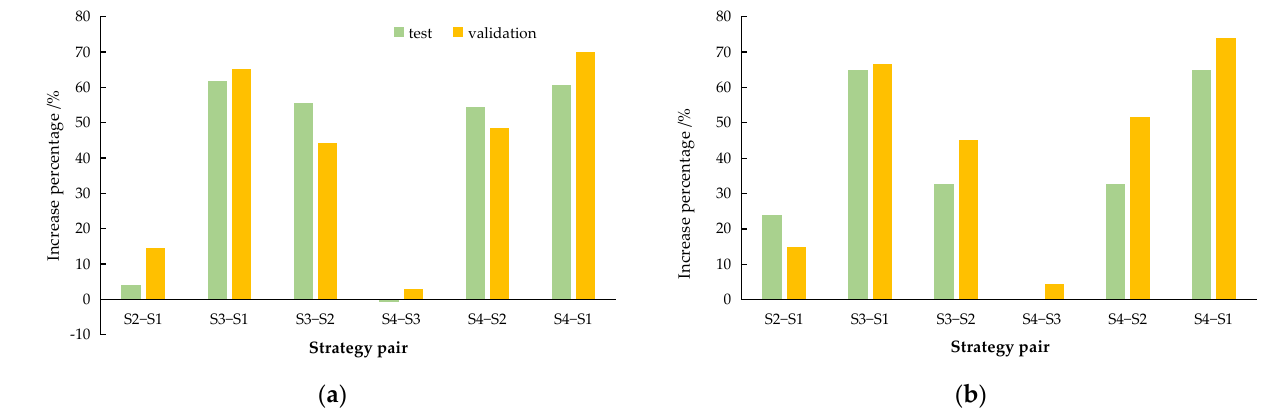
Figure 8. Assessment metric change comparison of different pairs of training strategies. ( a ) Overall accuracy; ( b ) Overall F 1 score. S1 denotes the training strategy from scratch and with the initial 10 layers frozen; S2 denotes the training strategy from scratch and with no frozen layer; S3 denotes the training strategy of the pretrained network and with the initial 10 layers frozen; S4 denotes the training strategy of the pretrained network and no frozen layer. S2 − S1 means the difference of the accuracy metrics for S2 and S1, and the others are the same as this meaning.